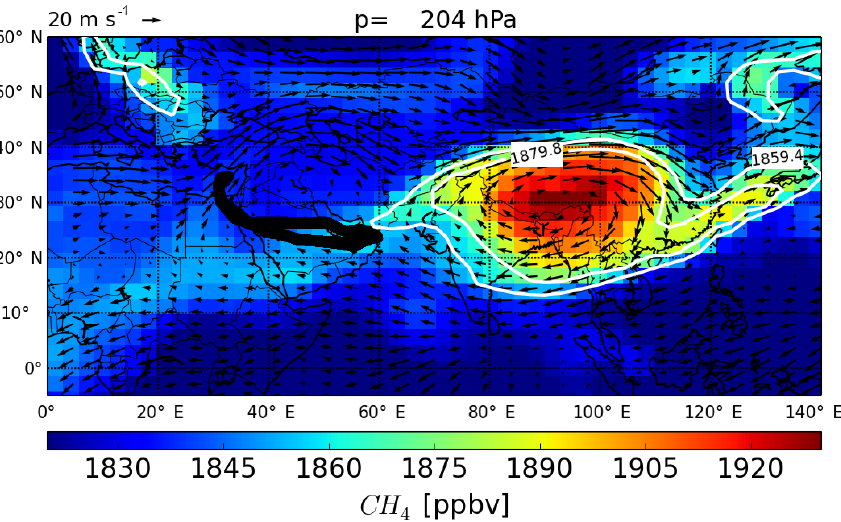
Figure 18. Tibetan anticyclone mode illustrated with wind field and CH 4 EMAC daily means at 204hPa (15 August 2015) and the associated flight tracks. White contours represent the CH 4 threshold and background values according to Sect. 3.1.